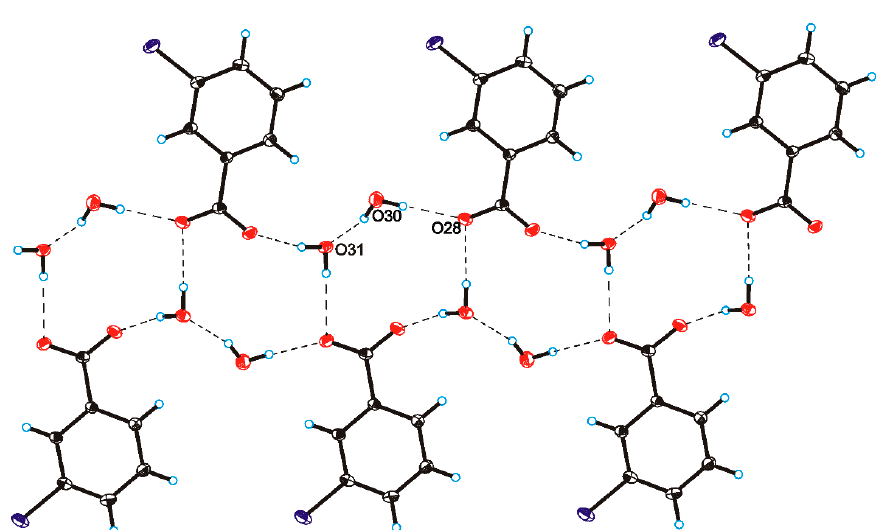
Figure 3. Supramolecular tape motif in the crystal packing of compound 3 (hydrogen bonds are represented by dashed lines).